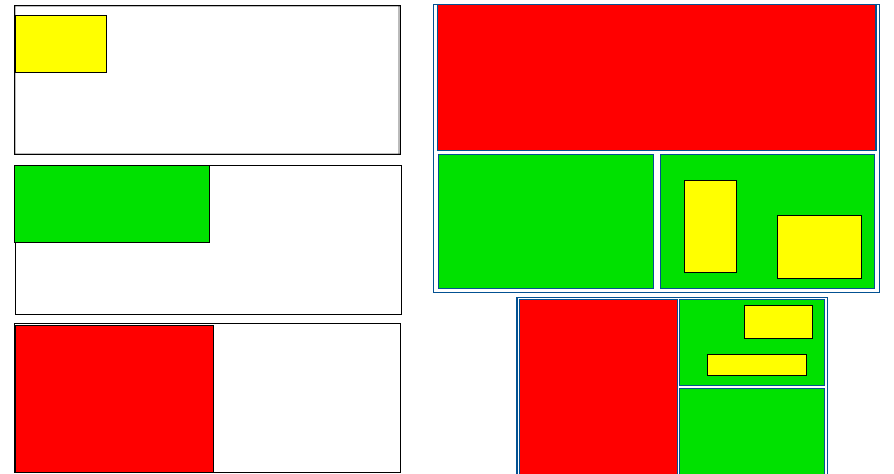
Figure 3. Sizing guide for the teen-informed coding tool. Note: There are three sizes: (1) Small, takes up less than ¼ of the ad (depicted in yellow), (2) Medium, takes up 1/4 of the ad (depicted in green), and (3) Large, takes up ½ of the ad or more (depicted in red).